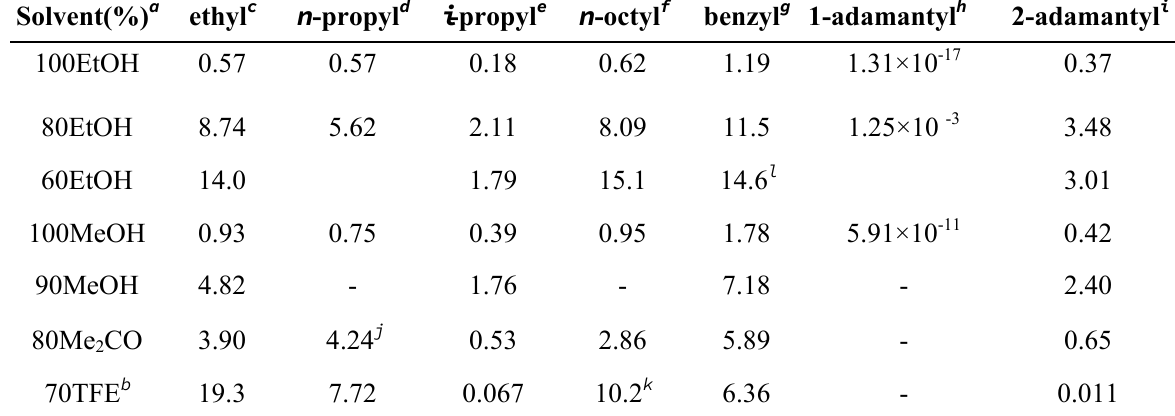
Table 3. The specific rate ratios (k binary solvents at various